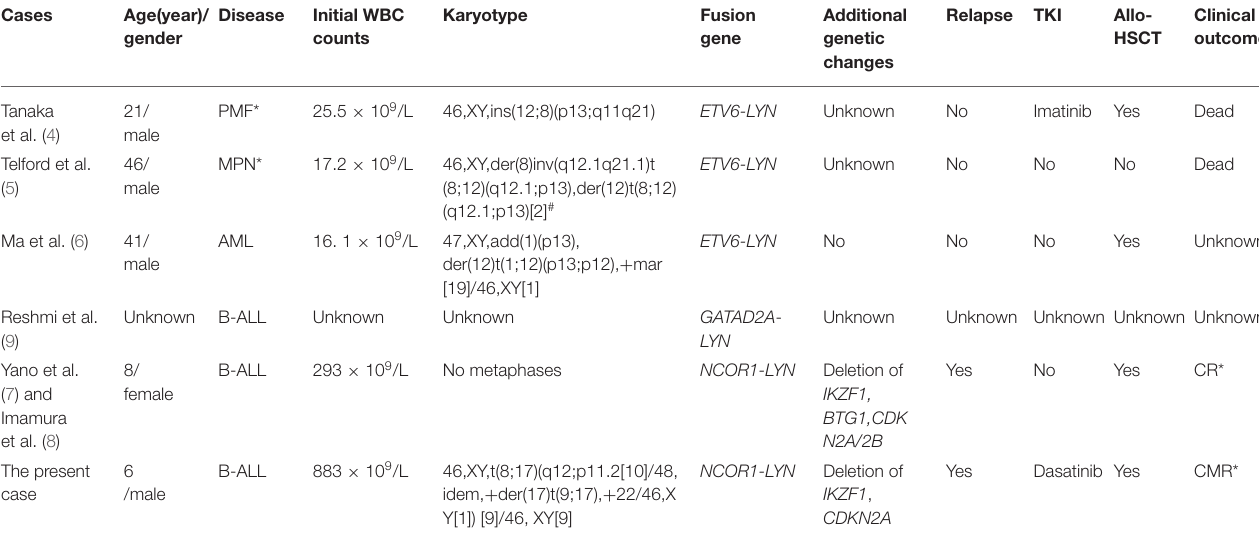
TABLE 1 | Characteristics of the reported and the present cases with a LYN rearrangement. Cases Disease Karyotype Fusion